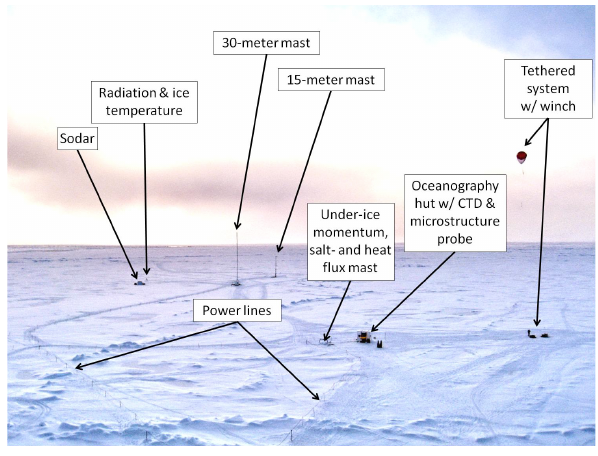
Fig. 8. Photograph of the “Met Alley” showing the location of the various sensor systems in vicinity of Oden .